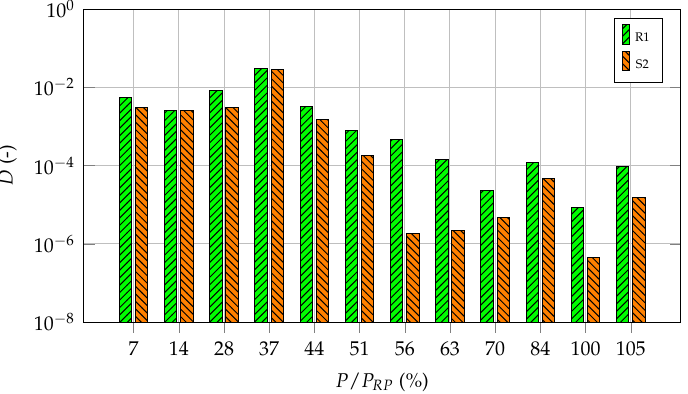
Figure 31. Damage factors at HS1 ( left ) and HS2 ( right ) for 1 year operating